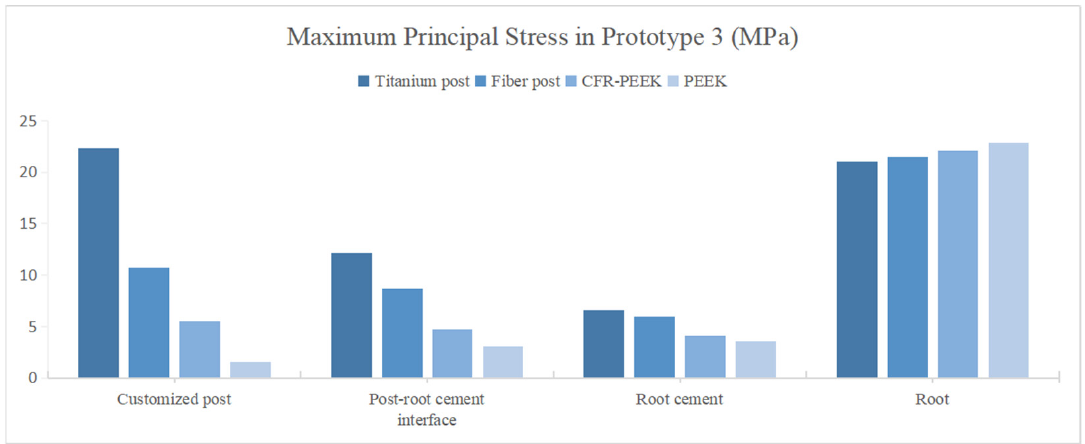
Figure 6. Peak value of MPS at post in Prototype 3.